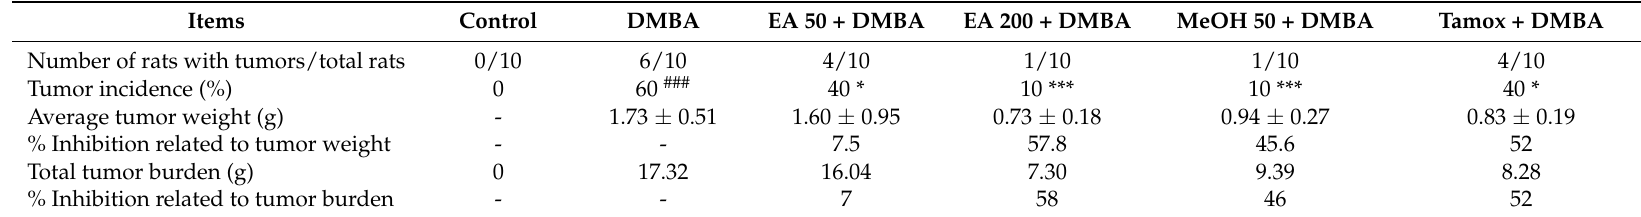
Table 4. Ovarian cancer chemopreventive activity of F. umbellata extracts after 20 weeks of